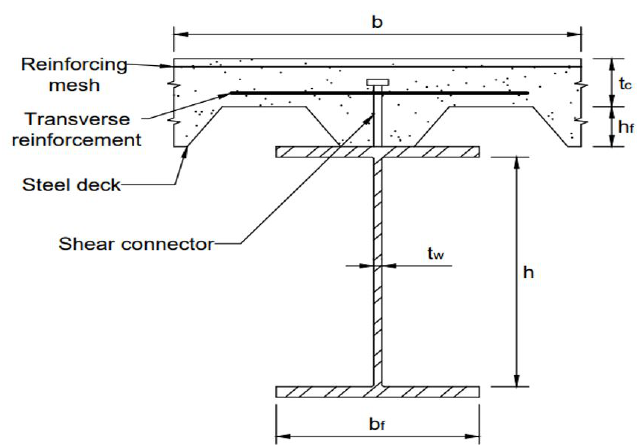
Figure 2. Cross-section of the composite girder and composite